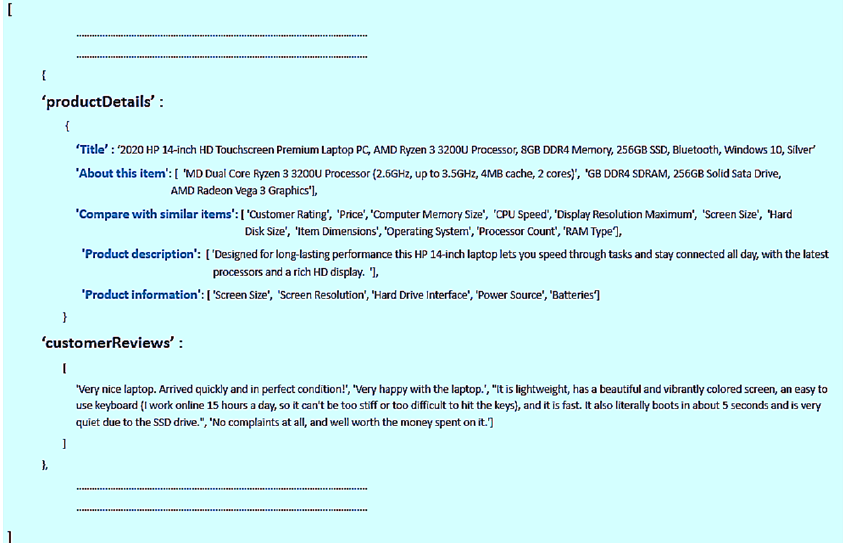
Figure 3. An example of a JSON (JavaScript Object Notation) object from Amazon.